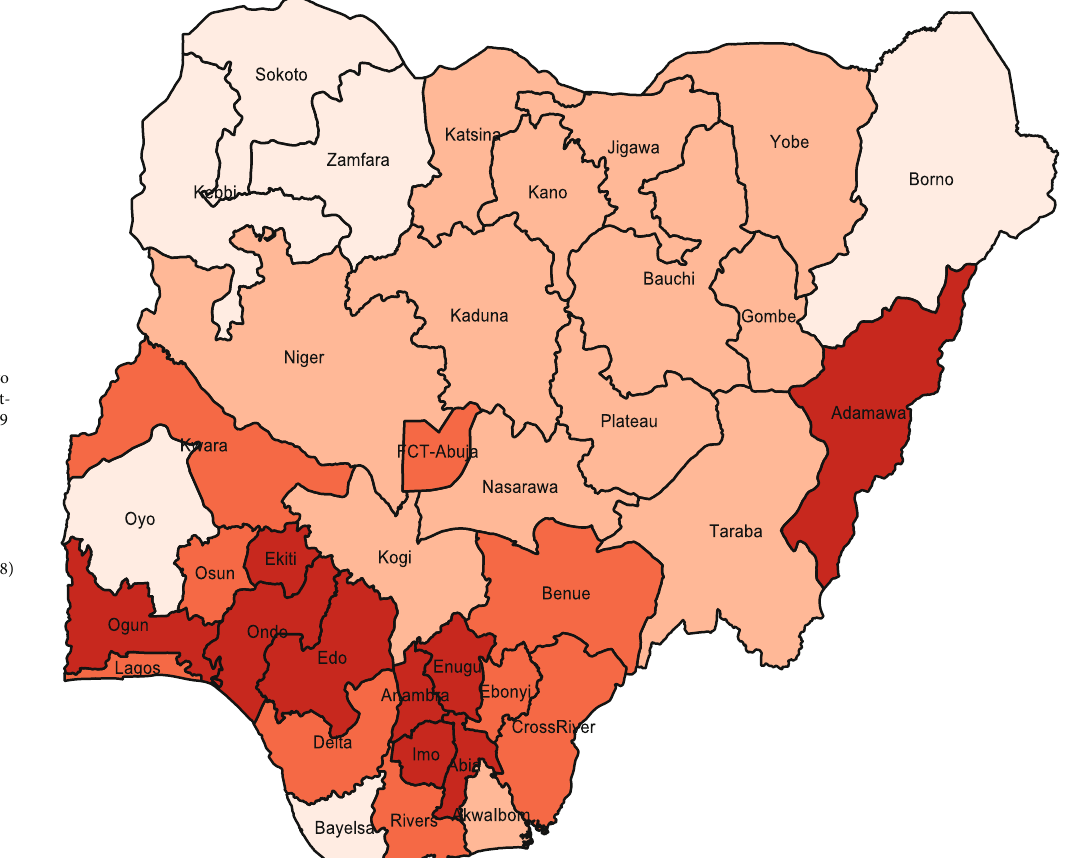
Figure 1: Prevalence of taking at least two doses of TTCV among fi rst-time mothers by states in